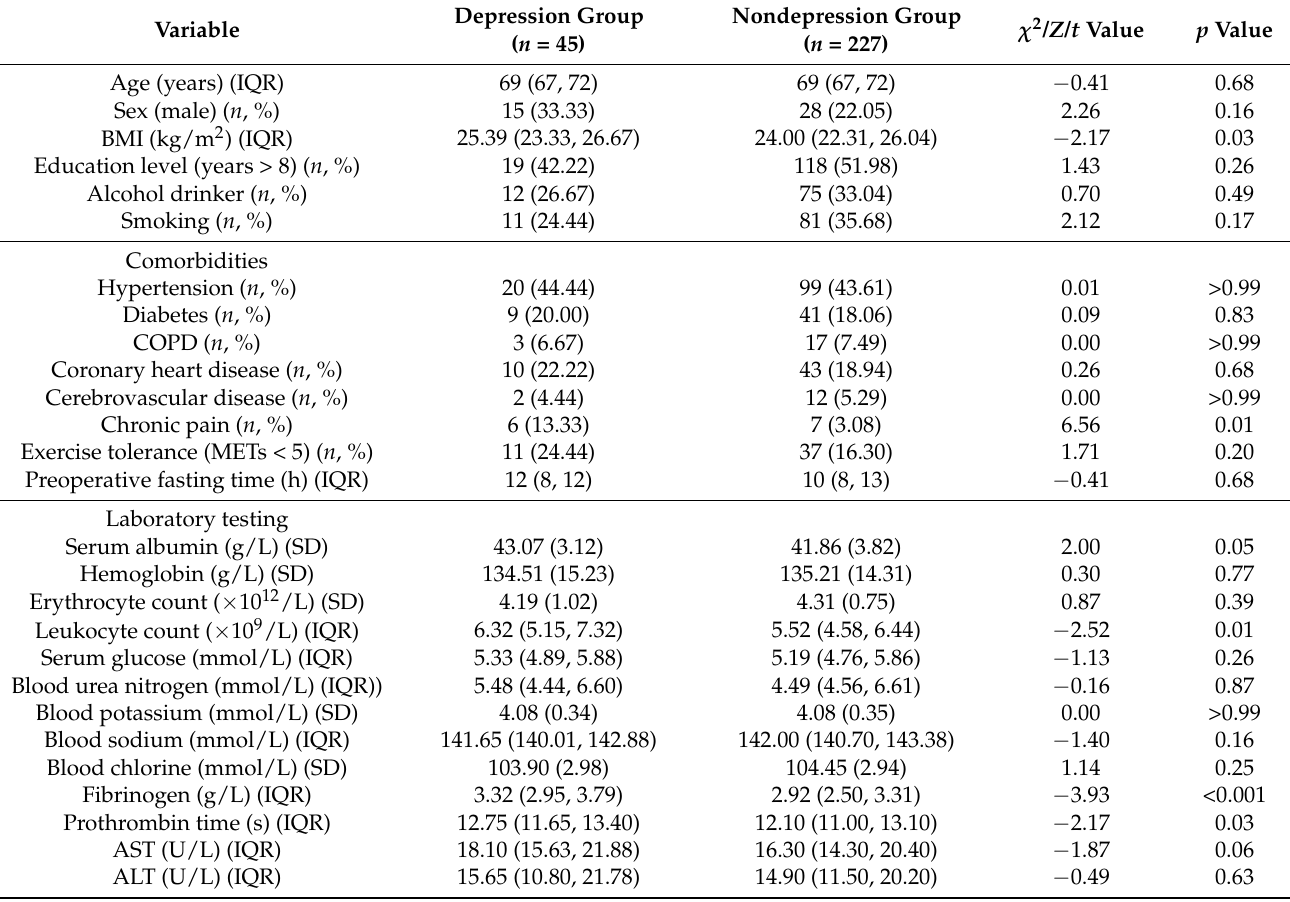
Table 1. Preoperative basic and clinical demographics of patients with and without depressive